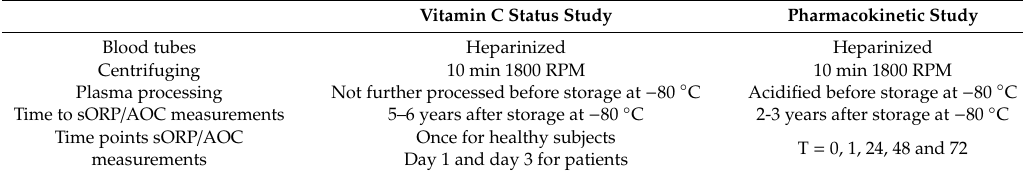
Table 1. Di ff erent sample processing conditions for each Table 1. Different sample processing conditions for each study.